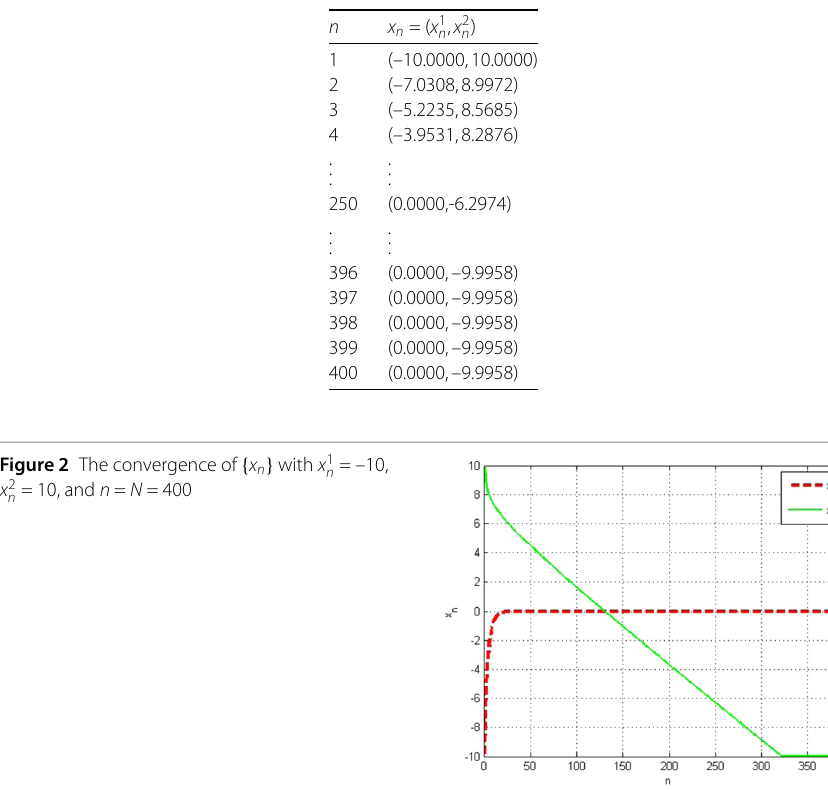
Table 2 The values of { x n } with x 1 n = –10, x 2 n = 10, and n = N = 400